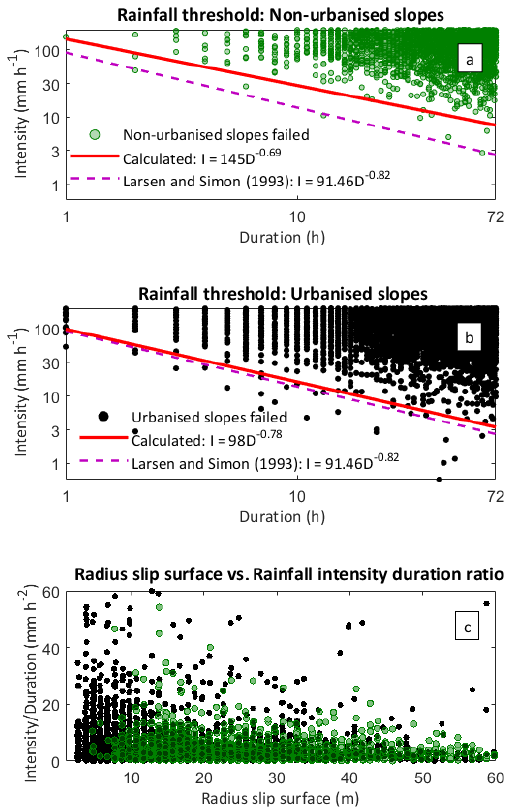
Figure 9. In (a) and (b) the red line represents the minimum rain- fall thresholds calculated from our stochastic sample (99.9% of the failed slopes in the sample are above the thresholds). Panel (c) rep- resents the radius of the slip surfaces of the recorded landslides plot- ted against the corresponding triggering rainfall intensity / duration ratio. Note as in (a) and (b) the x and y axis are in logarithmic base 10 scale, but the notation is linear for easier